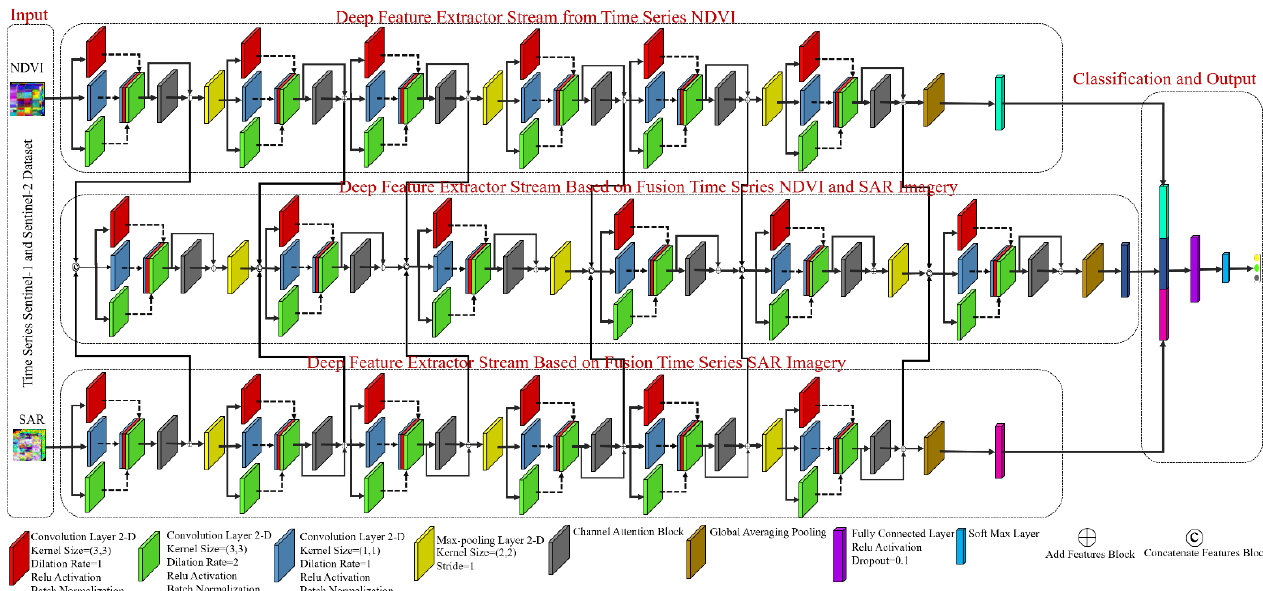
Figure 5. The proposed multi-streams framework for rice-type mapping.